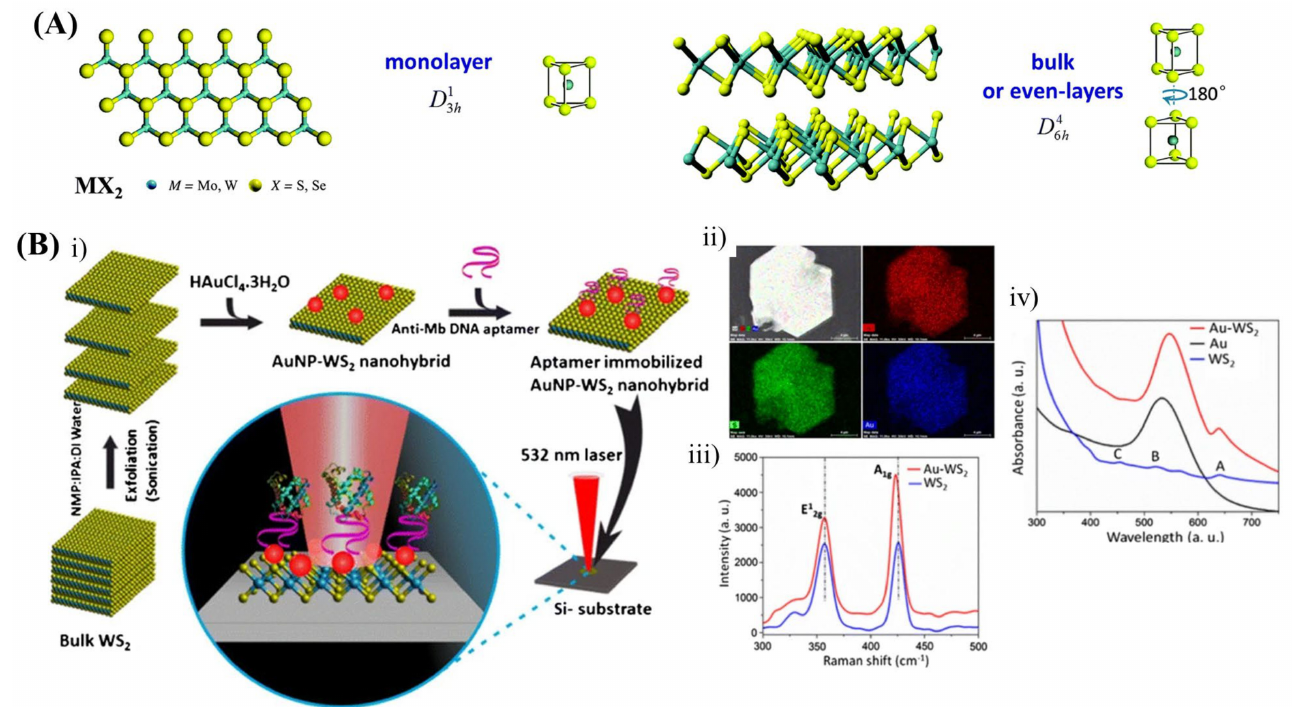
Figure 7. ( A ) The lattice structure of bulk and monolayer TMDs [162]. ( B ) ( i ) Schematic illustration of stepwise fabrication of Au − WS 2 nanohybrid-based SERS substrate for the detection of myoglobin, ( ii ) EDX elemental mapping, ( iii ) Raman spectra and ( iv ) UV–Vis spectra of the nanohybrid